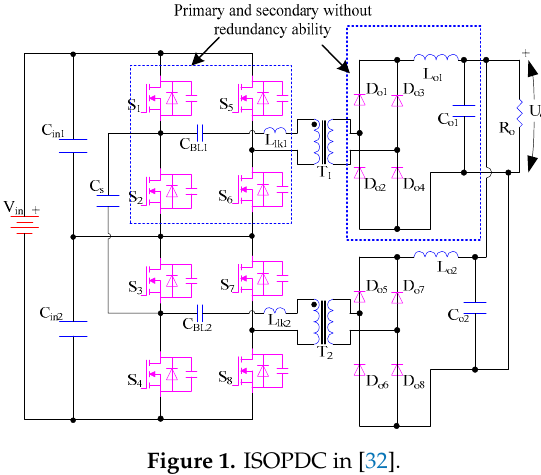
Figure 1. ISOPDC in [32].